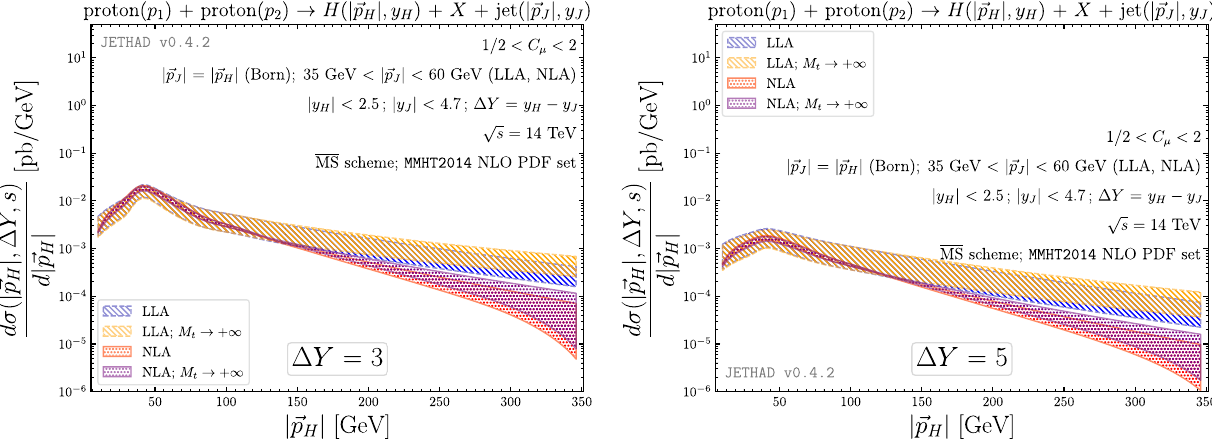
Fig. 8 p T -dependence of the cross section for the inclusive Higgs-jet hadroproduction for 35 GeV < | (cid:5) p J | < 60 GeV, (cid:6) Y = 3 , 5. Shaded bands give the combined effect of the scale variation with the uncertainty coming from the phase-space numerical integration